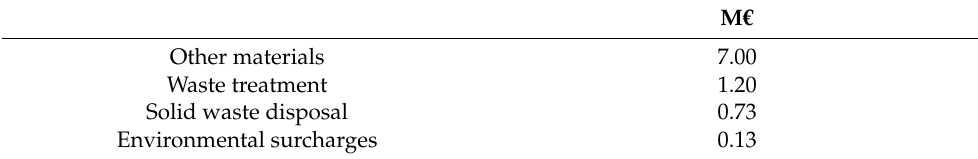
Table 2. Other variable operating costs.